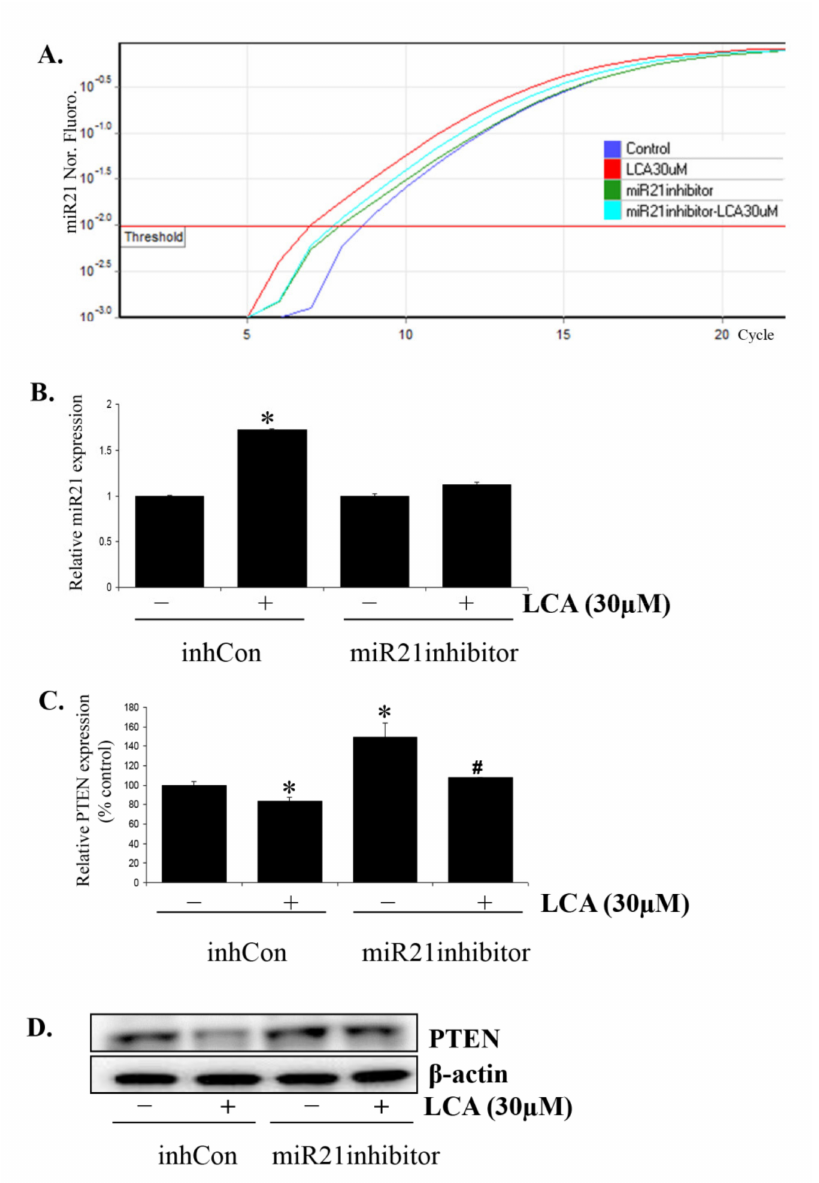
Figure 7. miR21-inhibitor rescues PTEN expression inhibited by LCA. HCT116 cells were transfected with 50 nM inhibitor negative control (inhCon) or miR21 inhibitor and treated with LCA for 24 h. The cells were then checked for miR21 expression by Realtime-PCR ( A , B ) and PTEN expression by Realtime-PCR ( C ) and Western blot ( D ). * p < 0.05 versus control; # p < 0.05 versus only LCA. The above data represent the means ± SD from triplicate